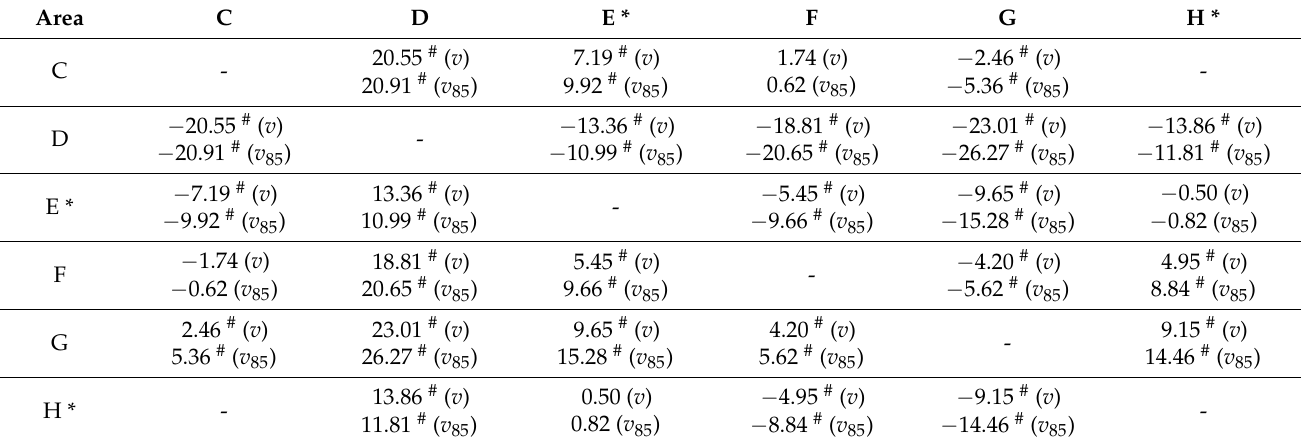
Table 5. Speed differences and speed consistency for different median opening lengths in different